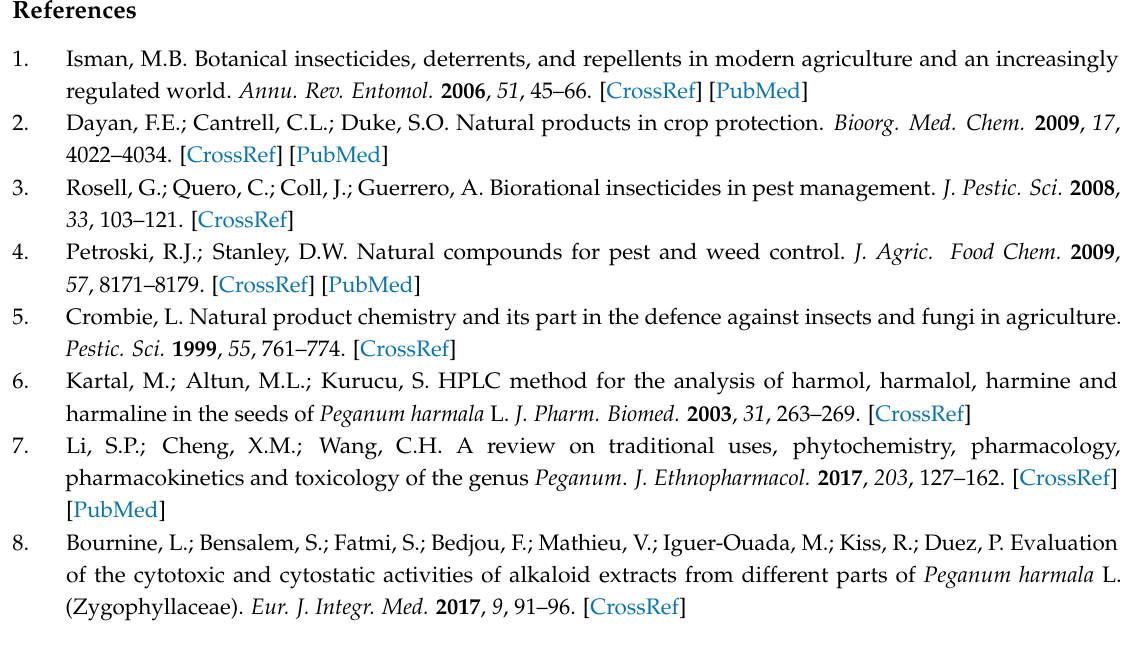
Supplementary Materials: The following are available online. Figure S1. Representative photographs of cell morphological change induced by compound 5 at various concentrations for 24 h, respectively. Figure S1. Agarose gel electrophoresis analysis of genomic DNA of cells treated by harmine at various